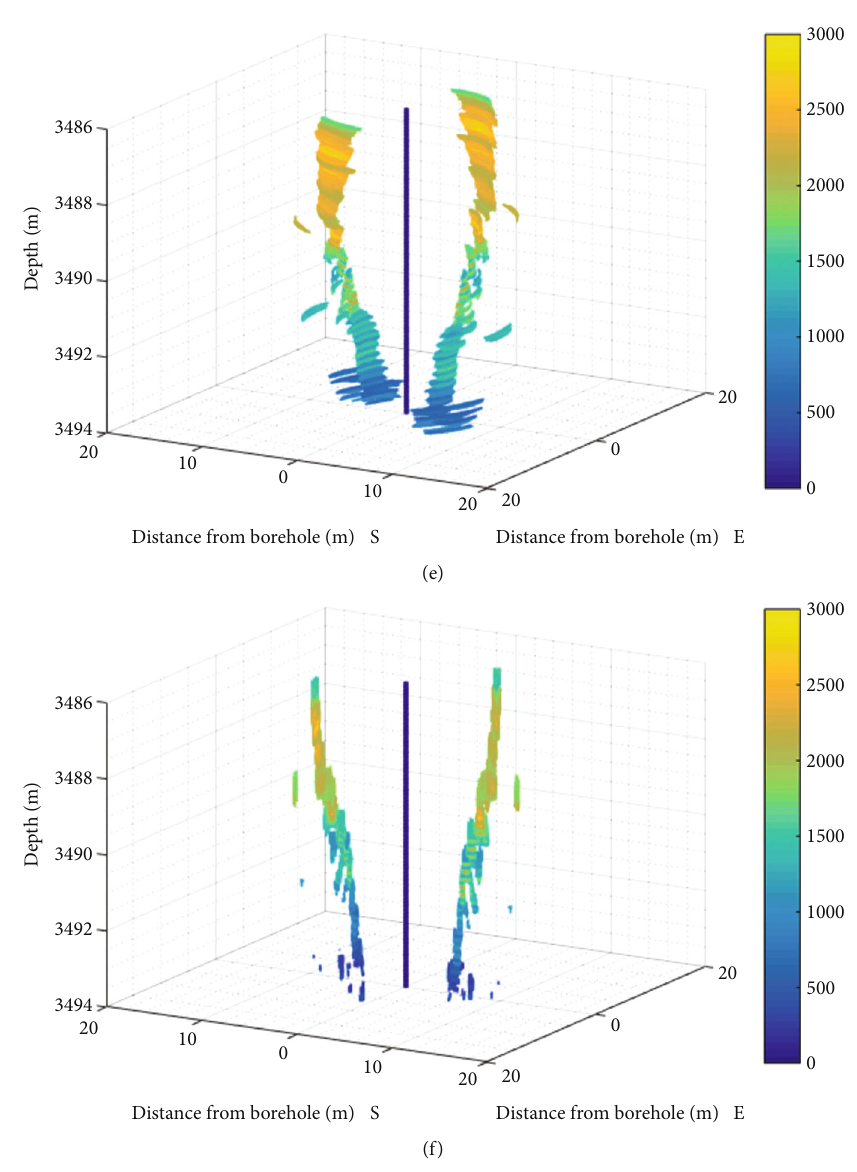
Figure 7: Three-dimensional display of fractures near the borehole by dipole re fl ection acoustic logging. (a) The section at a depth point of 3490m. (b) The section at a depth point of 3490m after the process. (c) Front view of the east. (d) Front north view of the east after the process. (e) The vertical view of 15 ° in the north to south 140 ° . (f) The vertical view of 15 ° in the north to south 140 ° after the